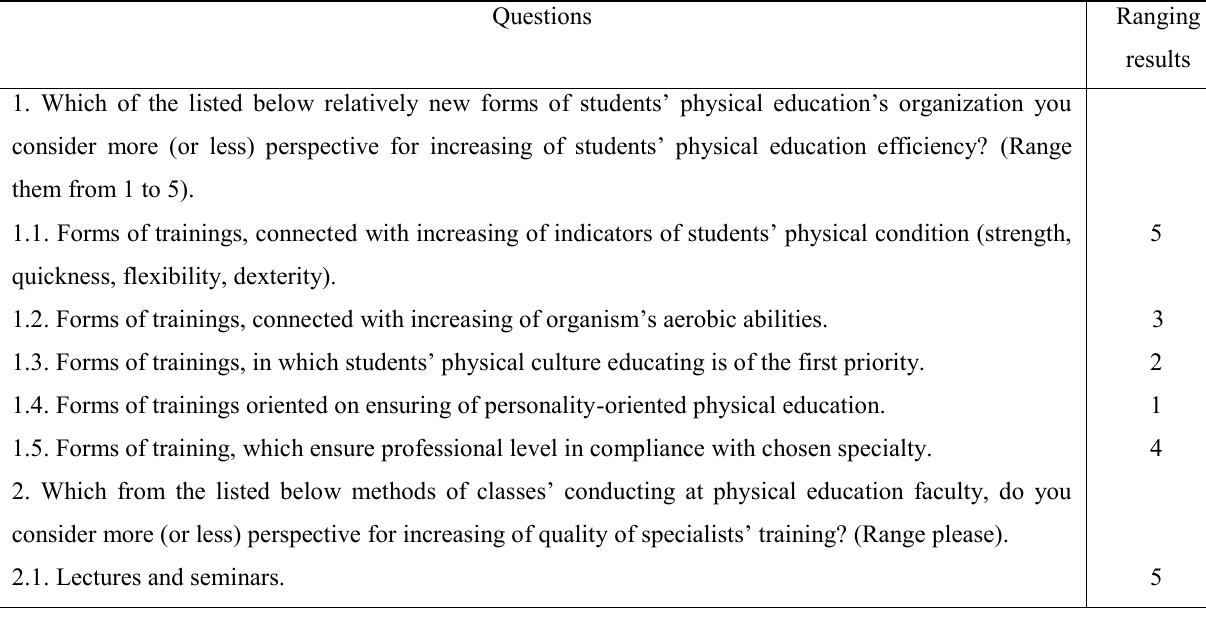
Results of experimental group students’ questioning (n =